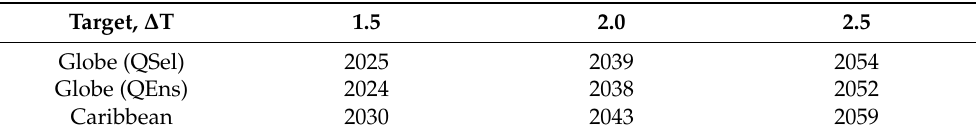
Figure 6. Graph showing 10-year running averages of temperature anomalies from 1900 through to 2100 for the Caribbean domain (blue) and the globe (orange), with respect to the pre-industrial period of 1860–1899. Values are for the ensemble mean of the six-member QUMP dataset. Vertical lines show the approximate years when the Caribbean (blue) and globe (orange) attain 1.5, 2.0, and 2.5 °C above pre-industrial values. Table 3. Table showing approximate years when global warming thresholds are attained for the six-member selected subset (QSel) and the 17 QUMP (QEns) runs. The years when the Caribbean attains the same temperatures are also shown for